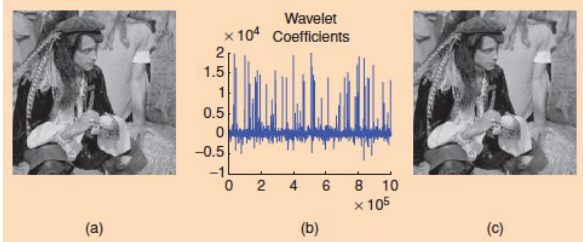
Fig. 3: the original image (a), its wavelet coefficients (b) and reconstructed image (c) after zeroing of the small